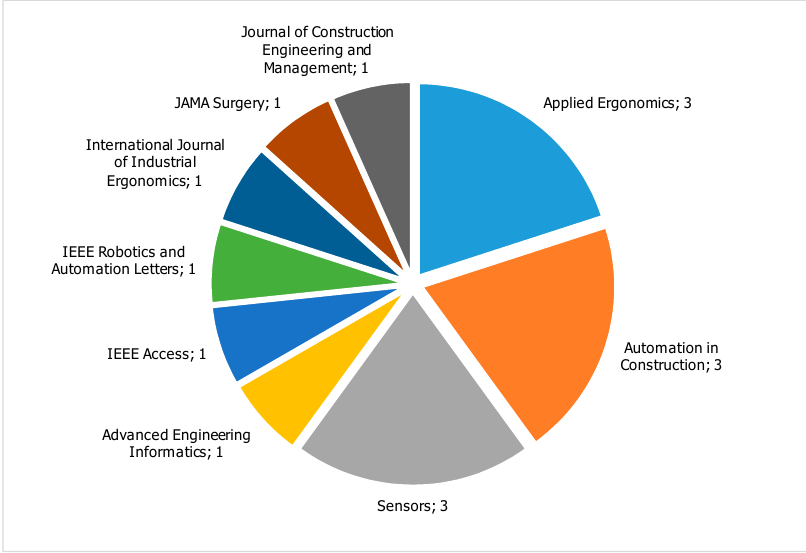
Figure 3. Distribution of the journals that published relevant papers.